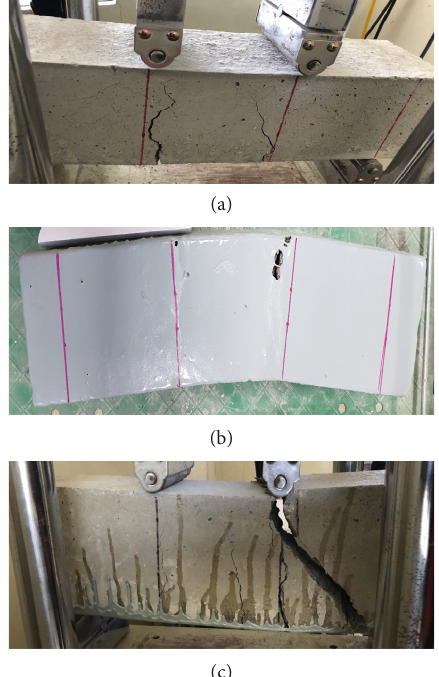
Figure 6: Failure modes of R-series specimens of (a) RP, (b) R33, and (c)